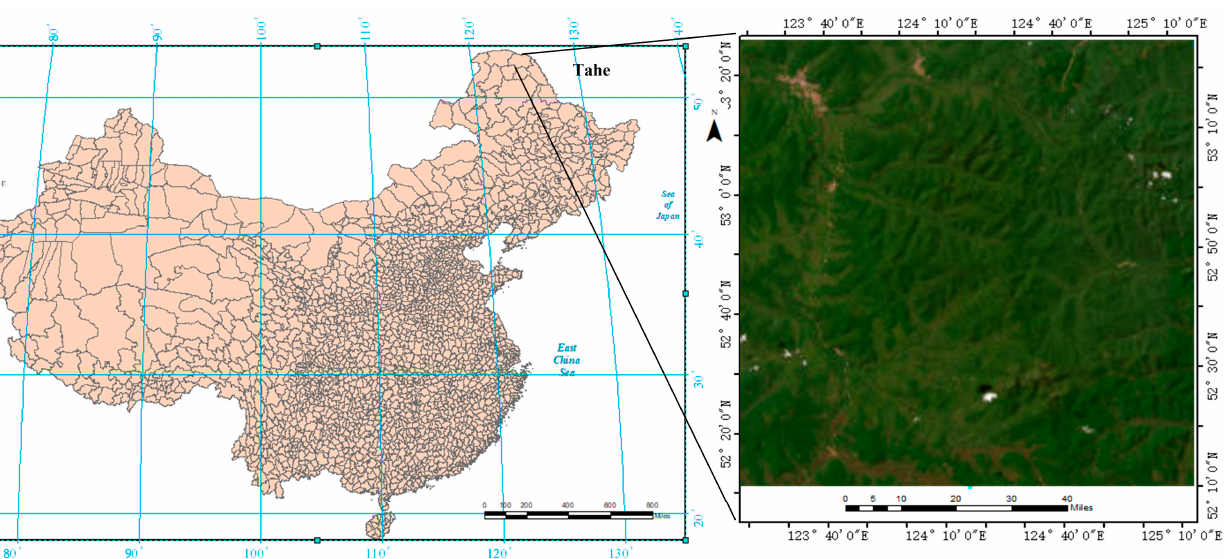
Figure 1. Map of the study